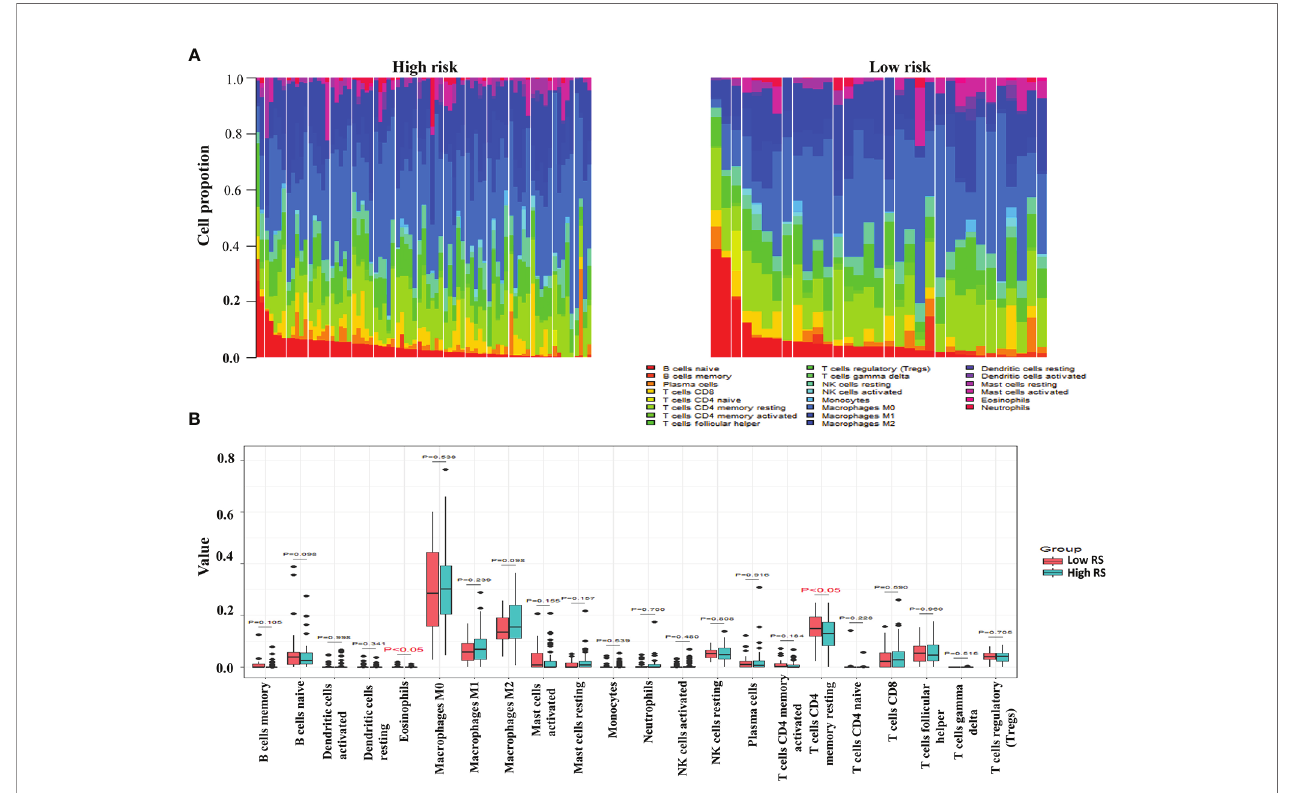
FIGURE 9 | Differences between leukocyte subsets in the high-risk group and the low-risk group in The Cancer Genome Atlas (TCGA) cohort. (A) Mean proportions of 22 immune cells in the TCGA cohort. (B) Differential immune cell type expression was observed between the high-risk group and the low-risk group in the TCGA